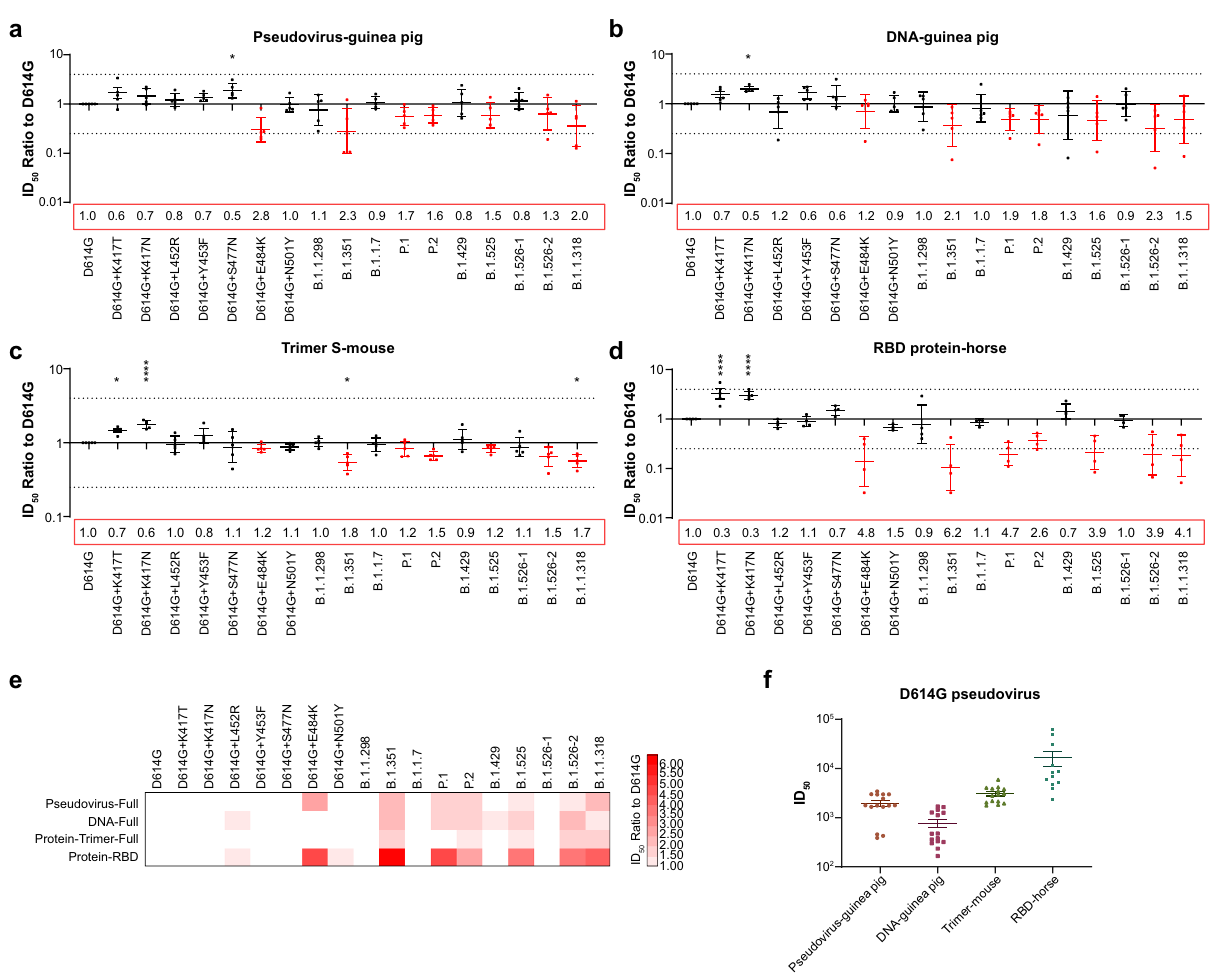
Fig. 5 Neutralization analyses of animal immunized sera. Serially diluted serum preparations were incubated with pseudotyped SARS-CoV-2 variants as indicated. The remaining procedure is identical to the procedure in Fig. 5. ID 50 ratios between the variants and the D614G reference strain are presented. a – d Dot plots of each serum sample against multiple variants. Data are presented as means ± SEMs. Dashed lines indicate the threshold of fourfold difference. E484K-carrying variants are marked in red. Reduced neutralization, folds compared with the D614G reference strain, is labeled at the bottom of each plot. e Heat map of mean ID 50 ratio, compared with D614G. The shade of red indicates the degree of reduced neutralization (folds), as shown in the scale bar. f Neutralization ID 50 values of different immunized serum samples against pseudotyped D614G virus. All experiments were repeated three times. Asterisks indicate statistical signi fi